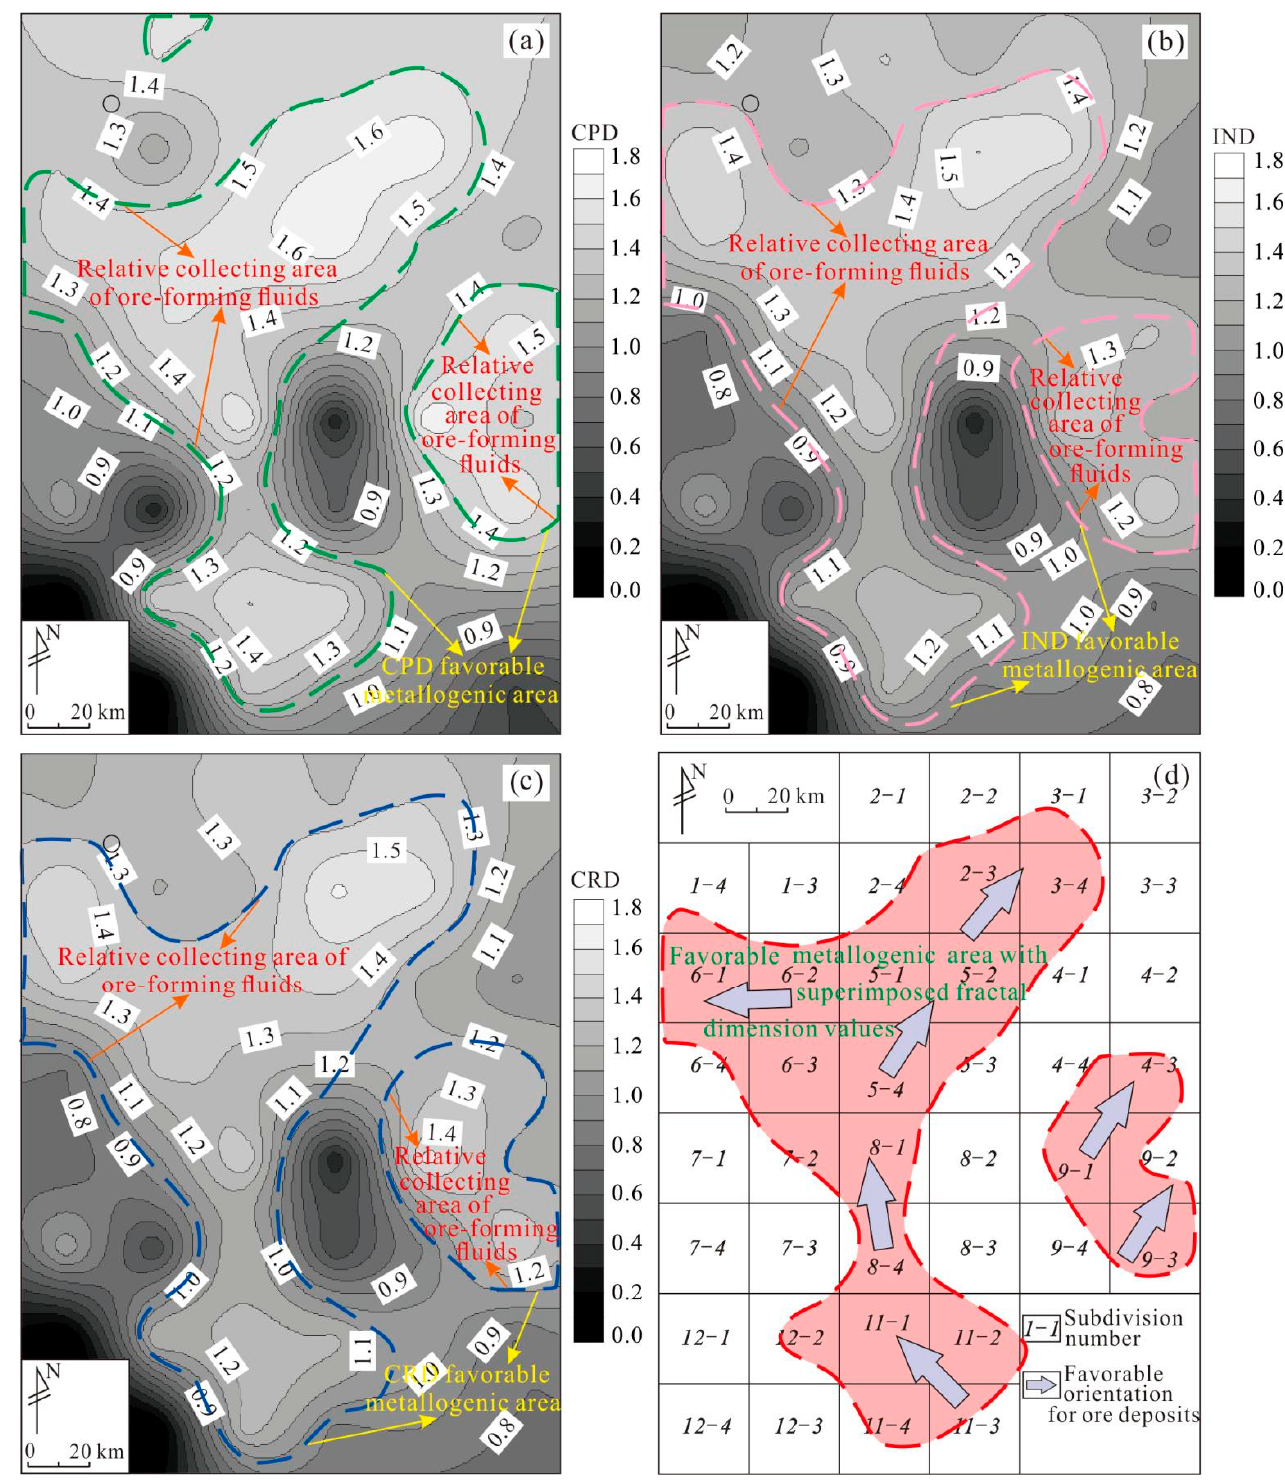
Figure 12. Fractal dimension favorable mining area. ( a ) CPD of fault favorable mining area; ( b ) IND of fault favorable mining area; ( c ) CRD of fault favorable mining area; and ( d ) Comprehensive consideration of fault fractal dimension value for favorable metallogenic area.